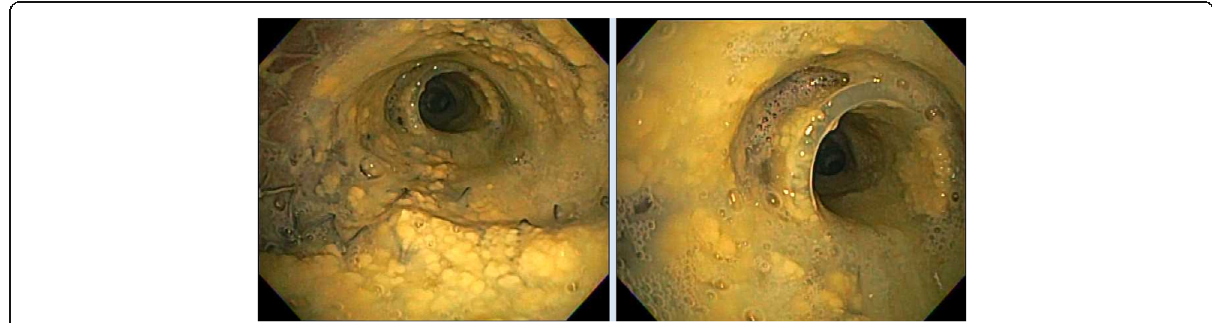
Fig. 3 Supplemental Digital Content 3. In situ tracheal stents with infected inspissated